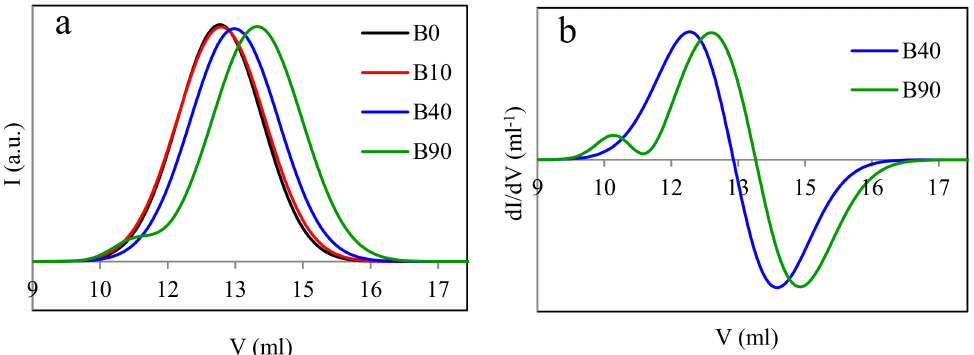
Figure 5. Results of GPC measurements for the samples with the predominant content of poly(butylene adipate- co -terephthalate) (PBAT) ( a —GPC curves for the samples type B; b —derivatives ( dI / dV ) of the GPC curves for the samples B40 and B90).